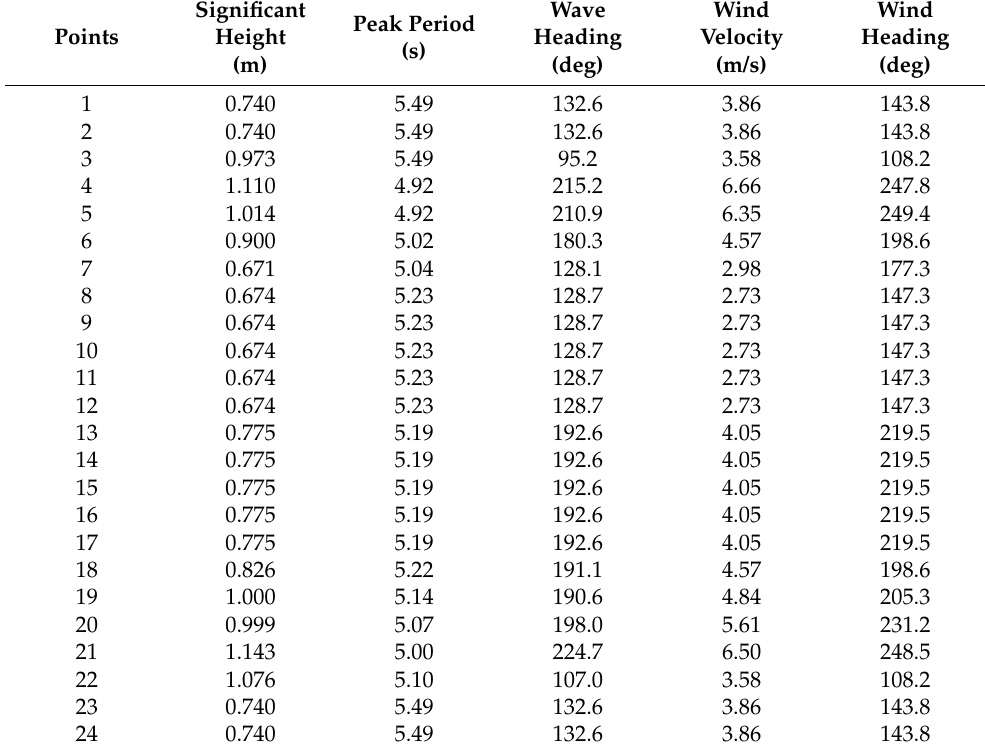
Table A4. Sea state per route point in June to August